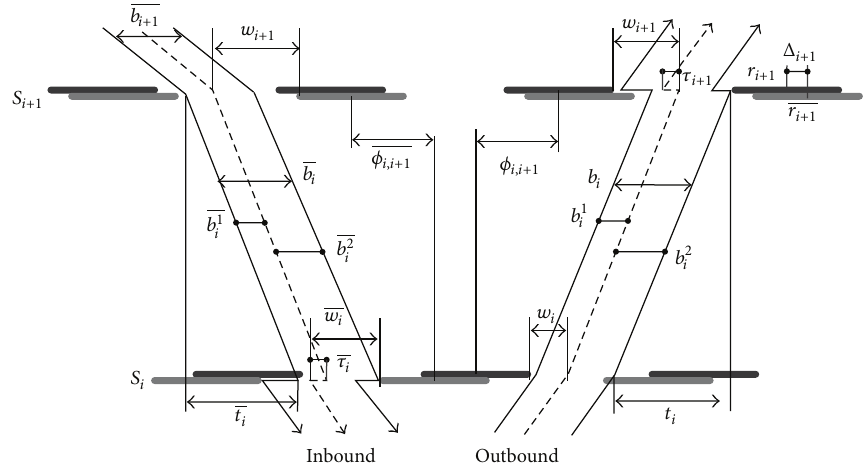
Figure 2: Time-space diagram of